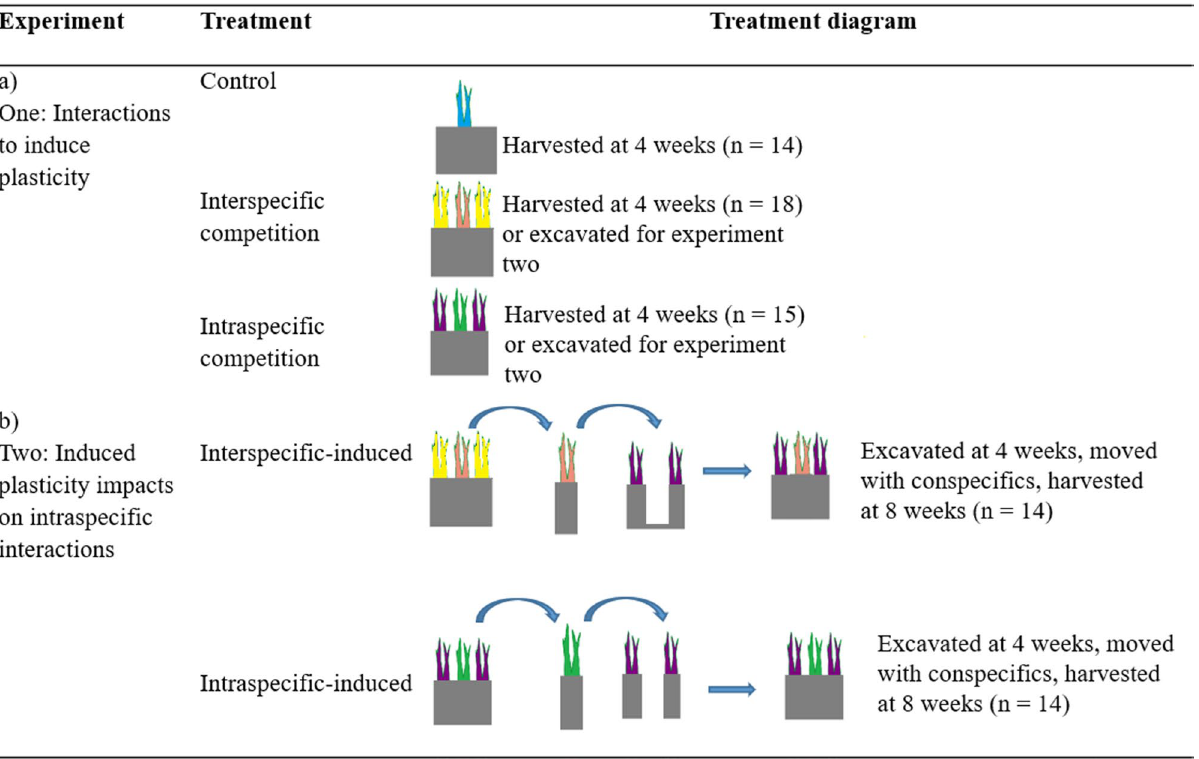
Figure 1. Interaction treatments and final sample size for the greenhouse experiments with Pascopyrum smithii focal plants (green, pink). Interspecific interaction treatments are with Bromus tectorum (purple) neighbors. ( a ) Experiment one using interactions to induce plasticity in the focal plant, ( b ) experiment two on the consequences of induced plasticity. Treatment sample sizes are in